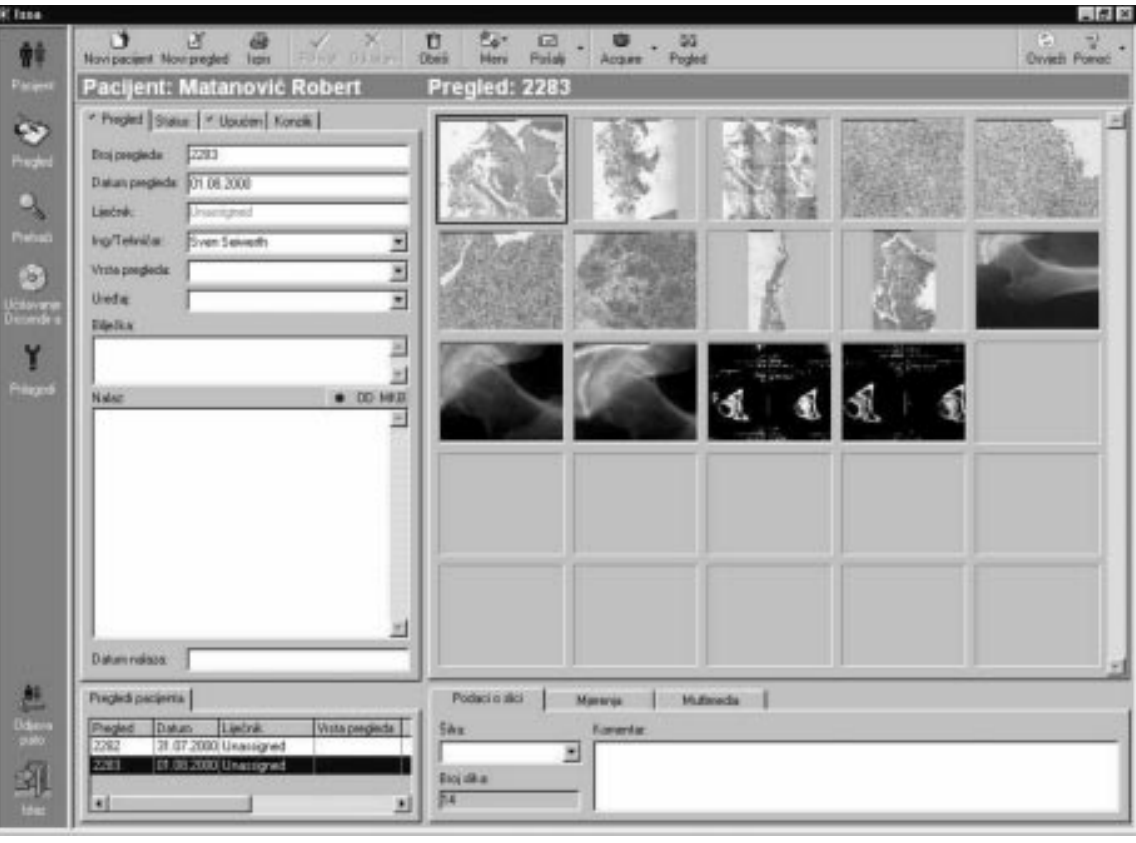
Fig. 1. ISSA patient data file (images from different